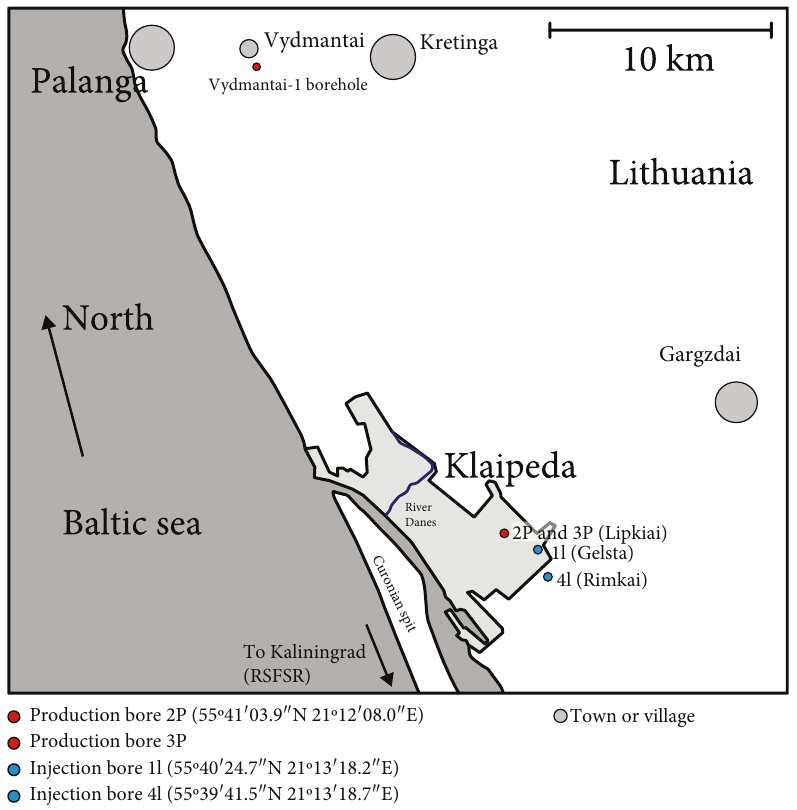
Figure 1: Map of coastal Lithuania, showing the locations of Palanga, Klaipeda, the Vydmantai borehole, and the Klaipeda Geothermal Demonstration Project (KGDP), consisting of boreholes 1I, 2P, 3P, and